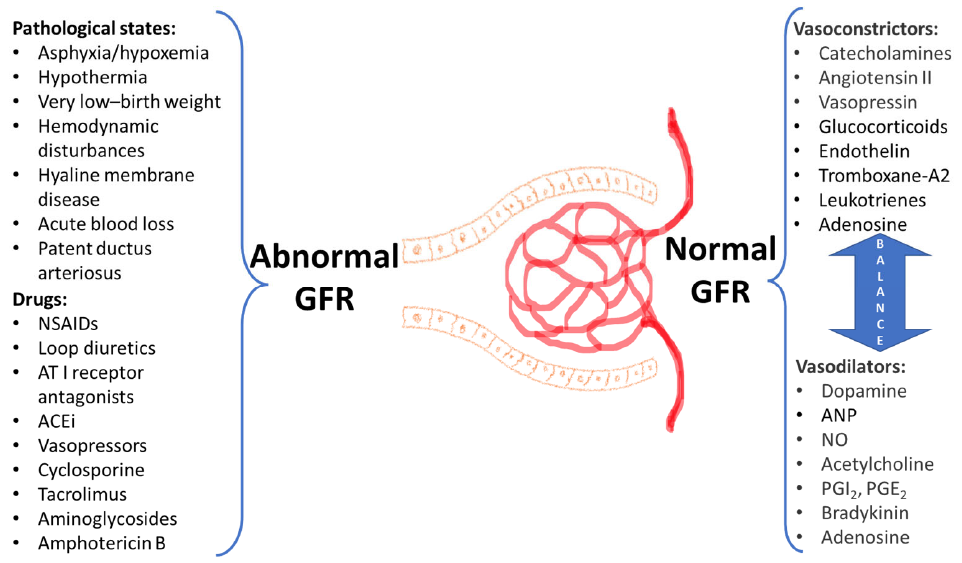
Figure 2. Factors affecting GFR in neonates.